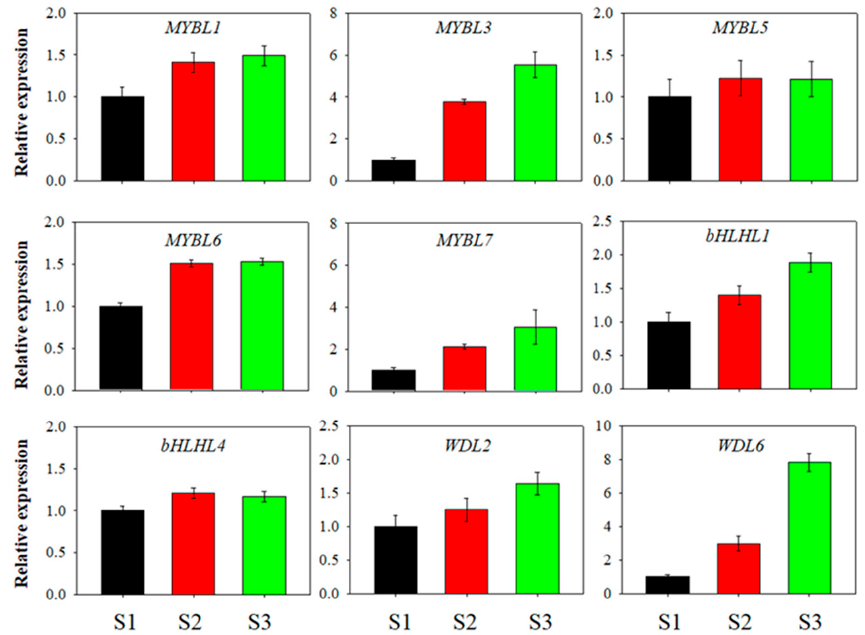
Figure 3: The quantitative real-time reverse transcription PCR (qRT–PCR) validation of RNA-sequencing relative expression estimation. Error bars are standard errors of the mean from three technical replicates.